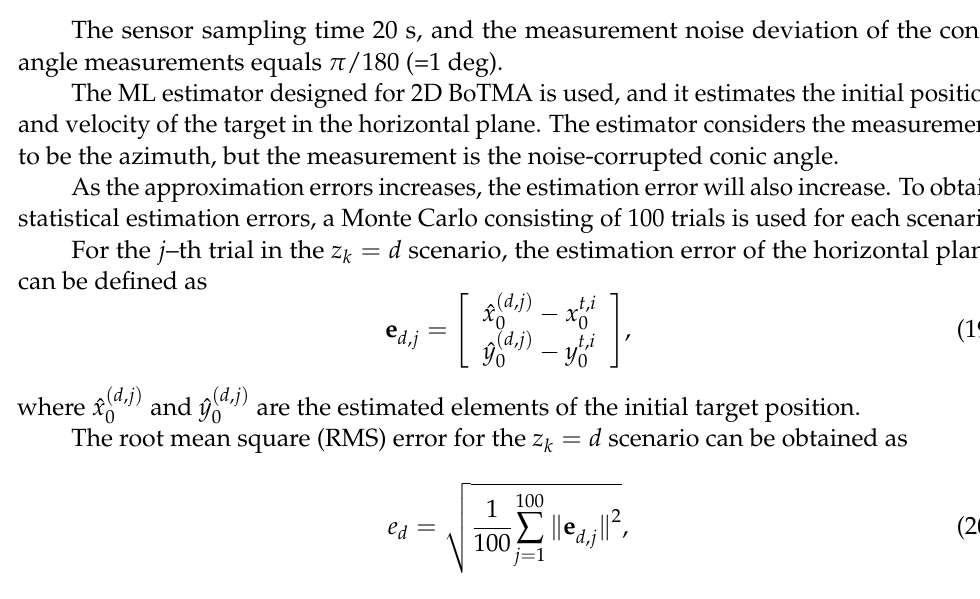
Figure 4. Difference between the conic angle and the azimuth (bearing).